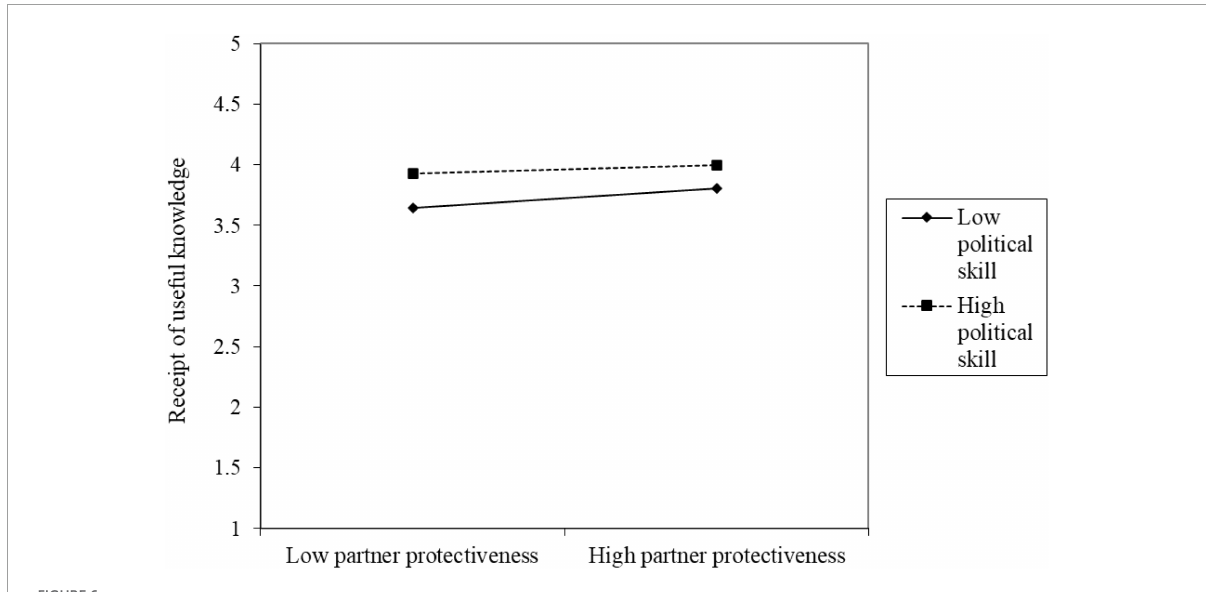
FIGURE6 Diagram of the interaction of political skills affecting partner protectiveness on receipt of useful knowledge.